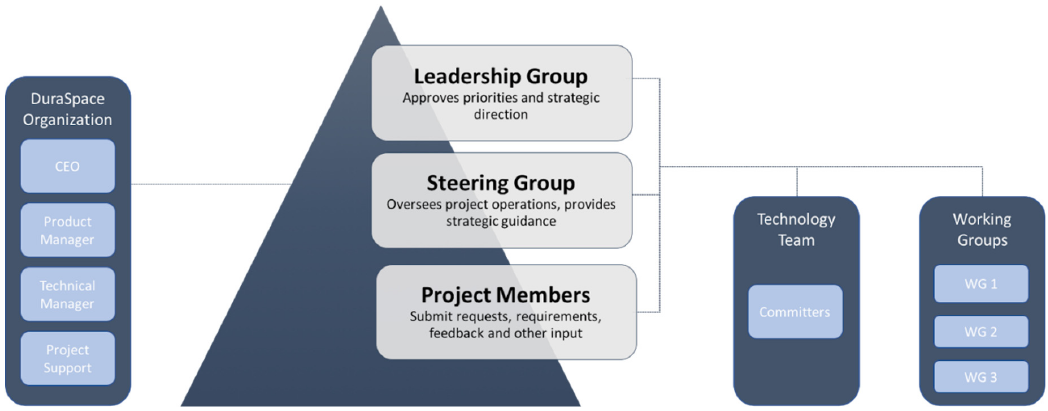
Figure 2. DSpace Governance Model.